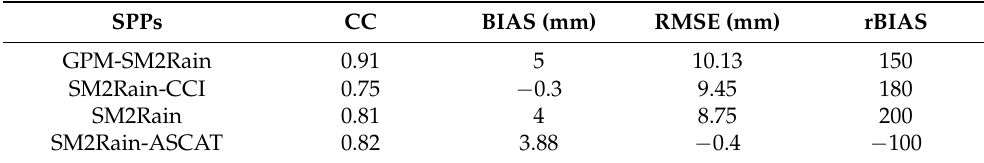
Table 3. The results of all evaluation indices on monthly scale.